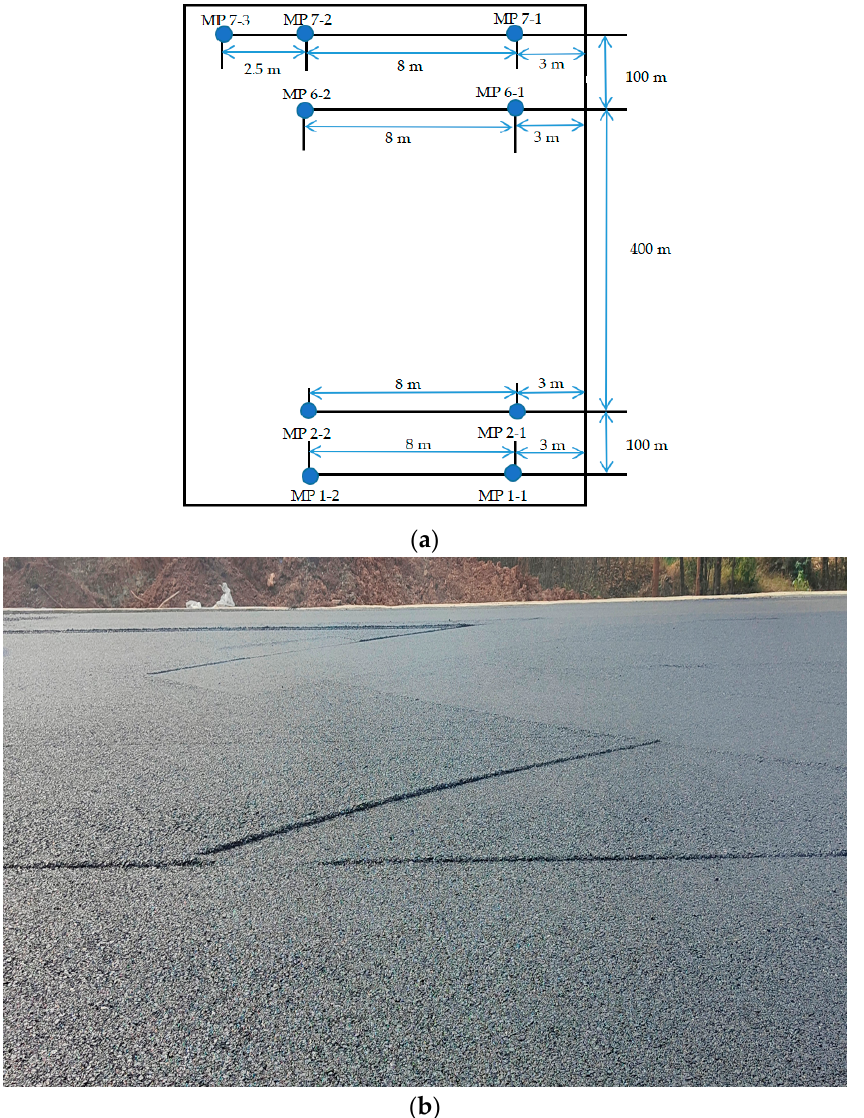
Figure 7. Location of road test points: ( a ) road test area; ( b ) actual road surface.